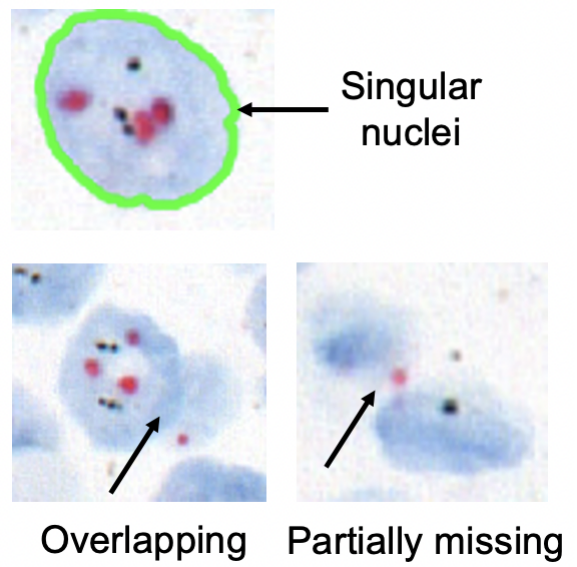
Figure 2. Examples of singular and non-singular